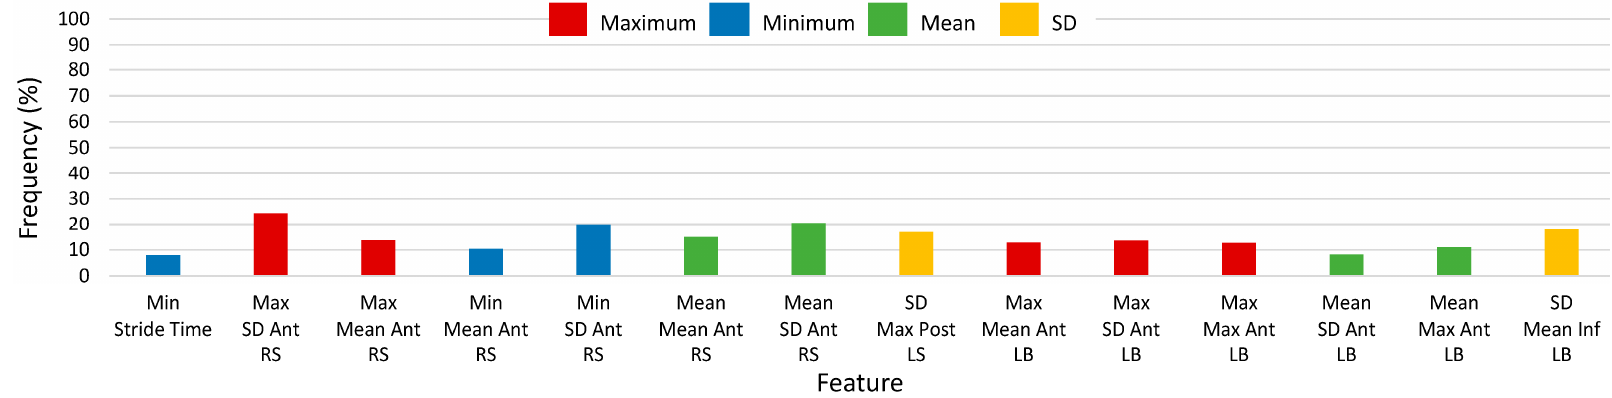
Figure 6. Histogram of selected straight-walking feature frequency above 8% (200) of 2500 total selections using the combination of Select False Positive Rate and Select False Discovery Rate methods (SEL) for 2500 random-shuffle-split iterations.